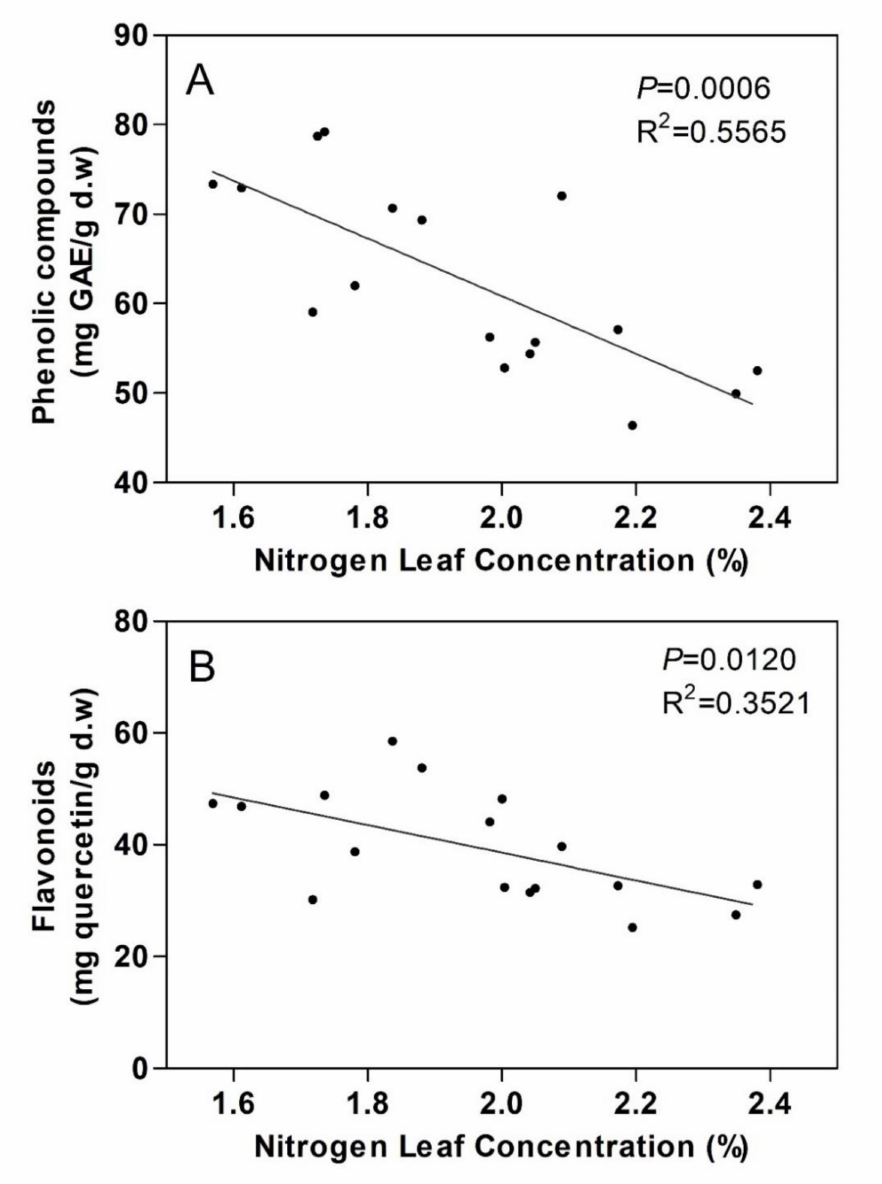
Figure5. Correlationof( A )leafphenoliccompoundconcentrationsand( B )leafflavonoidconcentrations with nitrogen leaf concentrations ( n =